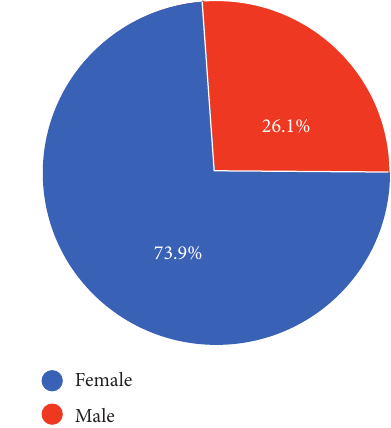
Figure 3: Gender of the participants of the